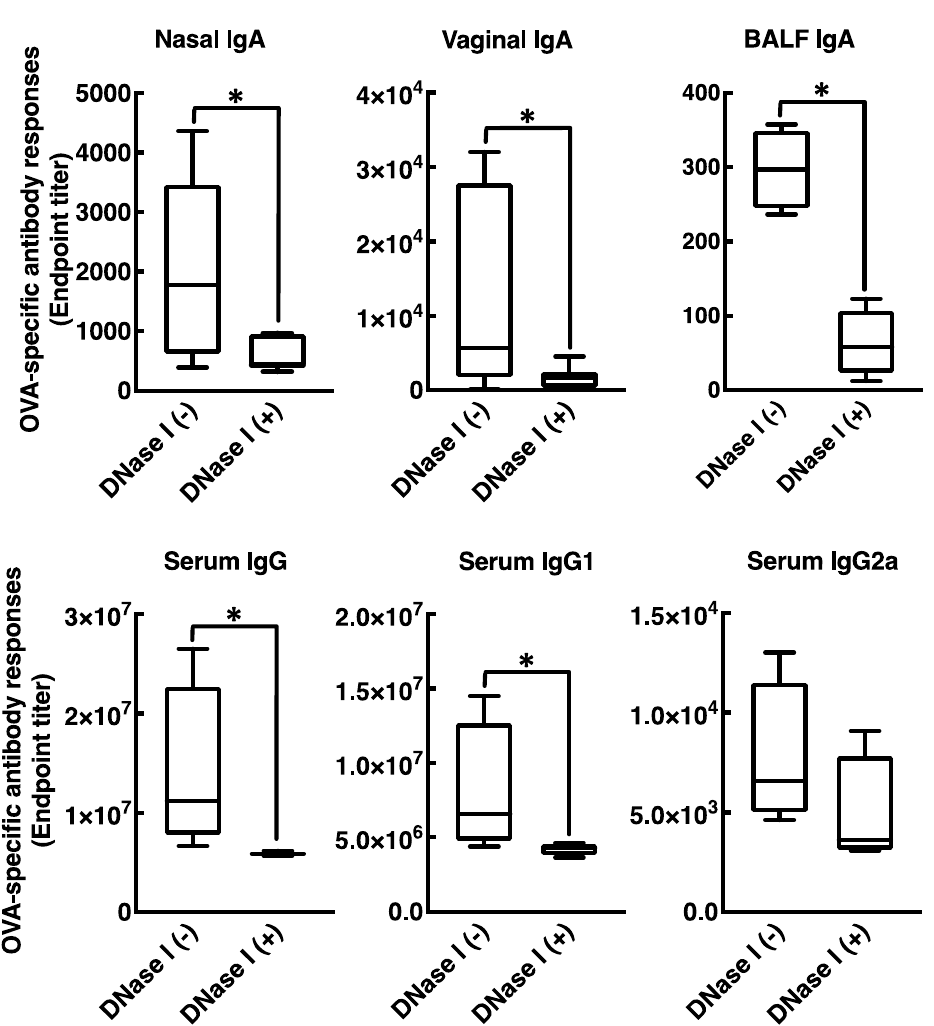
Figure 6. DNase I treatment attenuates antigen-specific antibody responses in BALB / cCrSlc mice immunized with OVA in combination with DOTAP / DC-chol liposomes. BALB / cCrSlc female mice were immunized intranasally (days 0, 7, and 14) with PBS, OVA (2.5 µ g / mouse) alone, or OVA (2.5 µ g / mouse) together with DOTAP / DC-chol liposomes (400 nmol / mouse). Three and 18 h after each immunization, mice additionally received DNase I (200 IU) nasally. OVA-specific nasal IgA, vaginal IgA, BALF IgA, BALF IgG, serum IgG, serum IgG1, and serum IgG2a titers at day 21 were determined by an ELISA assay. The data were acquired from at least three biologically independent experiments. The box-plot represents median values with 25th–75th percentiles with error bars indicating 5th–95th percentiles. Significant difference was calculated by Mann–Whitney U test. * p < 0.05.